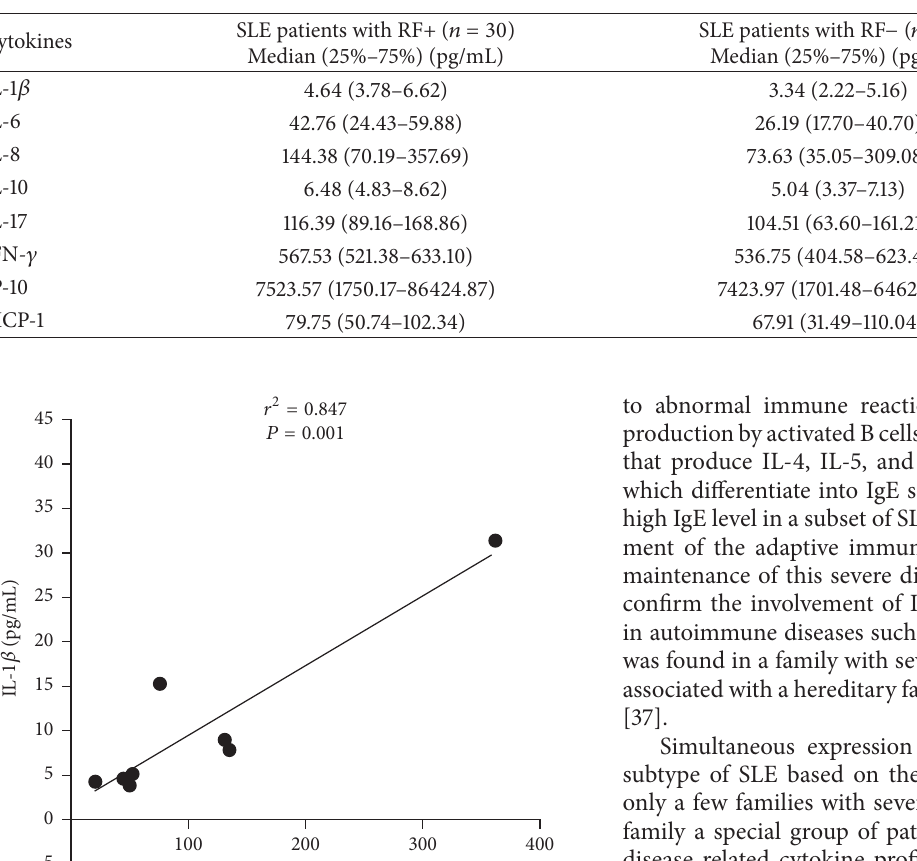
Table 5: Serum cytokine levels of SLE patients with RF+ and with RF − .